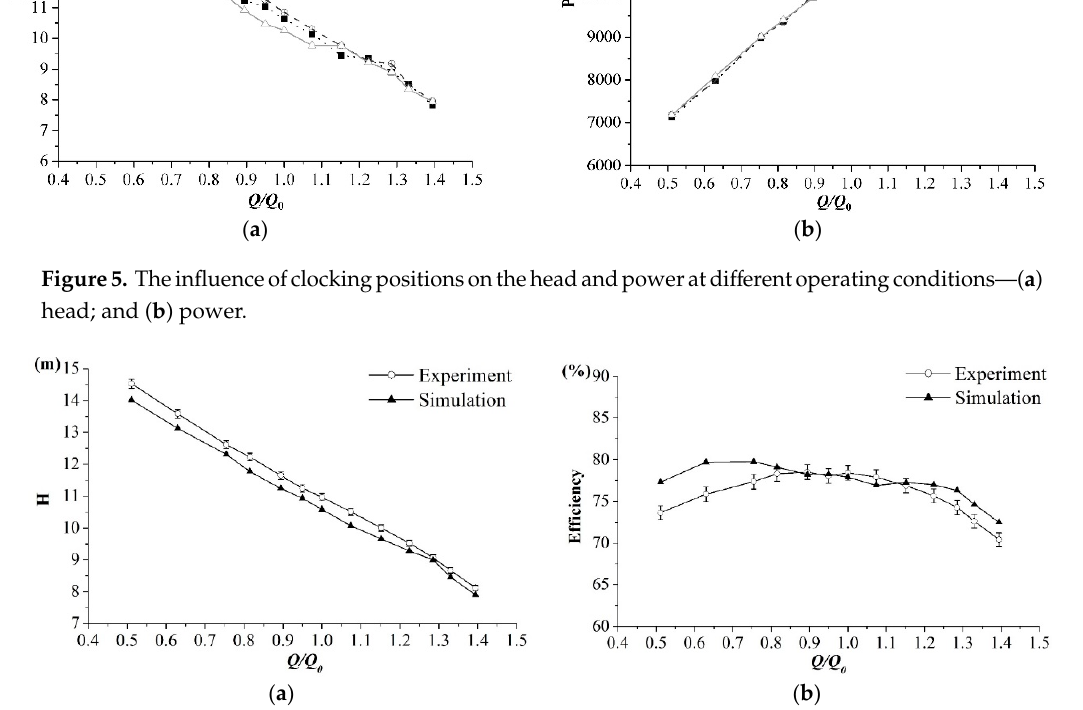
Figure 6. Comparison of the head and efficiency, between the numerical simulations and experimental results—( a ) head; and ( b ) efficiency.